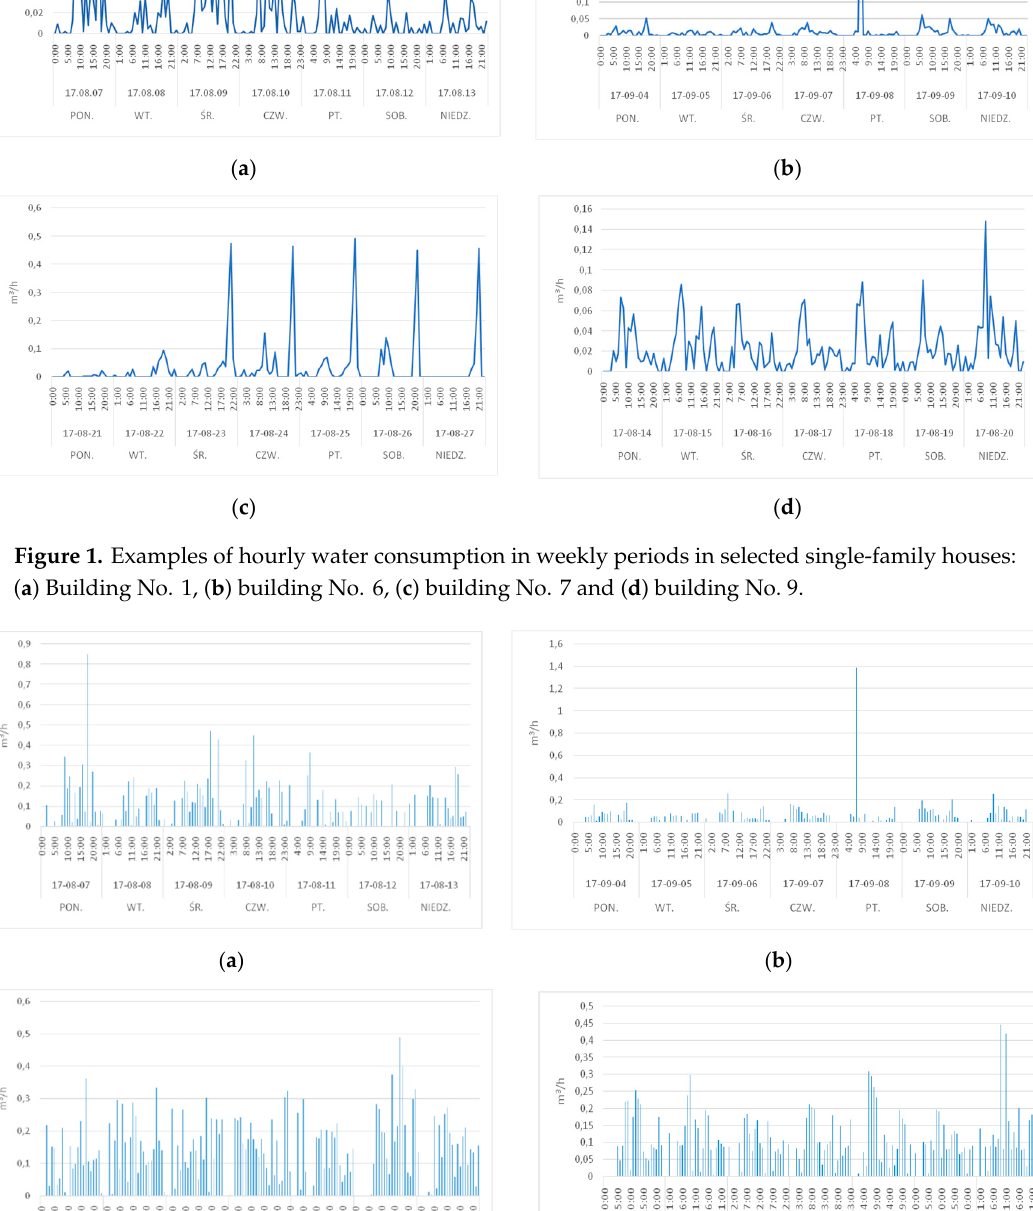
Figure 1. Examples of hourly water consumption in weekly periods in selected single-family houses: ( a ) Building No. 1, ( b ) building No. 6, ( c ) building No. 7 and ( d ) building No. 9.